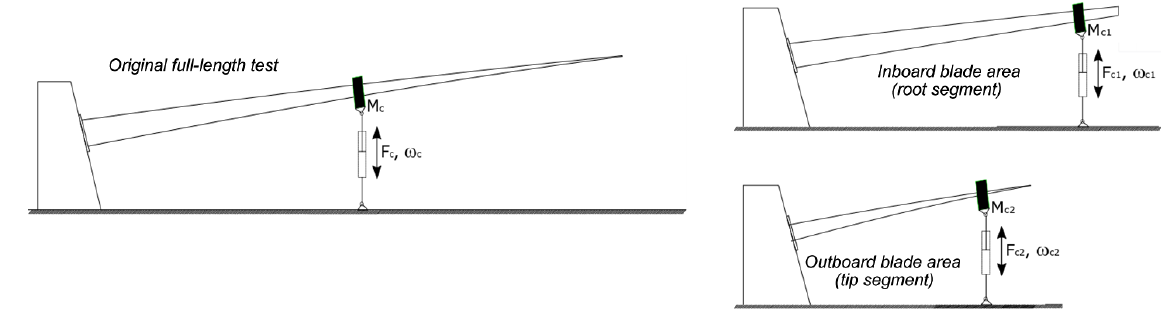
Figure 4. Comparison of blade fatigue test setup (full-length blade vs. segment blades).